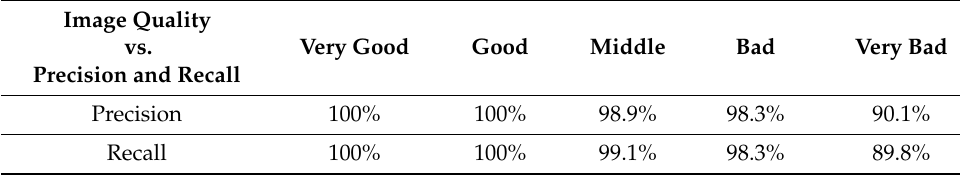
Table 2. The test results of a comprehensive benchmarking of our model (for text detection) with different document-image quality levels of our test dataset.